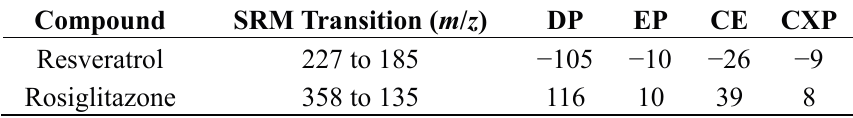
Table 2. LC-MS/MS parameters to detect resveratrol and